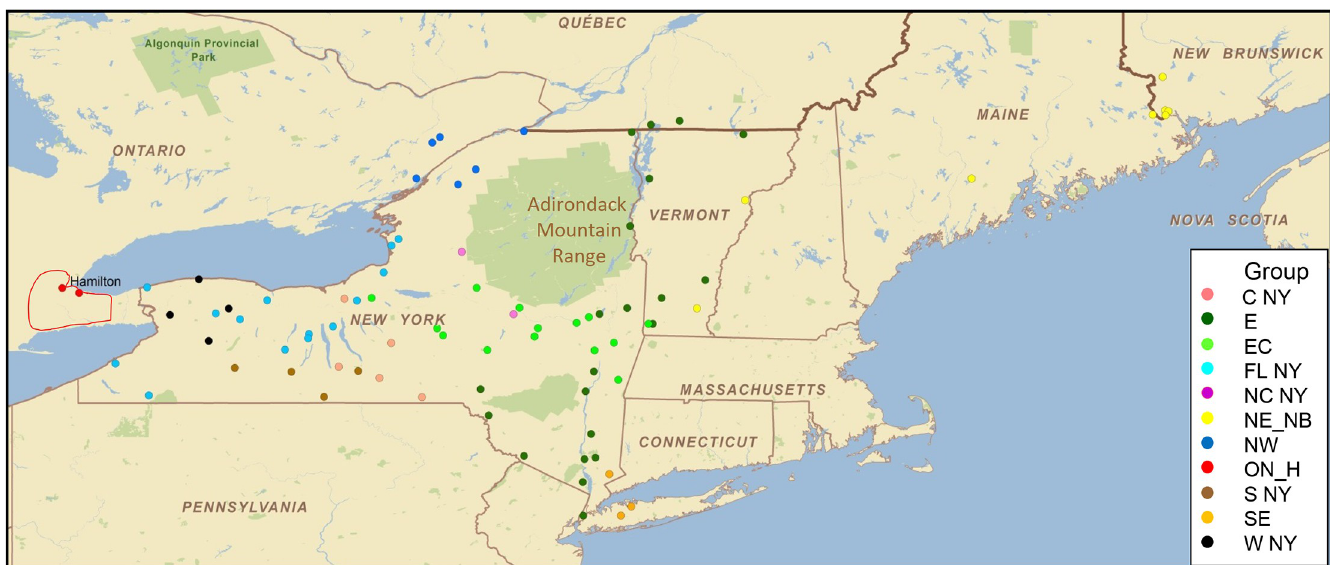
Fig 2. Distribution of the RRV variants across the northeastern USA and Canada border areas. The geographical locations of most samples analyzed in the phylogeny presented in Fig 1, including the position of the city of Hamilton, are shown. The extent of the outbreak area around the city as of June 2018 is indicated by a solid red line. Viral variants, as identified in Fig 1, are color-coded as indicated in the legend; ON_H identifies Hamilton RRV samples.